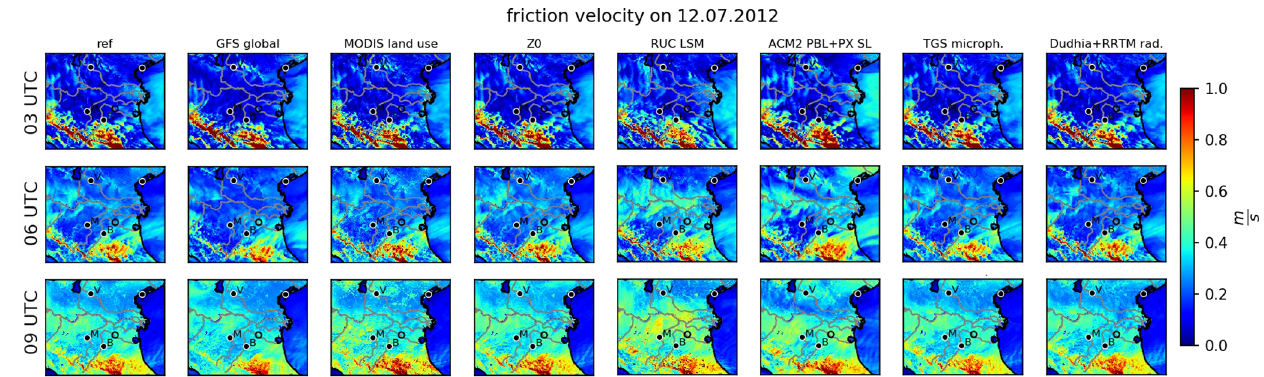
Figure 5. Friction velocities on 12 July 2012 at 03:00, 06:00 and 09:00UTC (coded by color) for different model configurations, including increased roughness length (“ Z 0”). Plotting conventions are like in Fig.